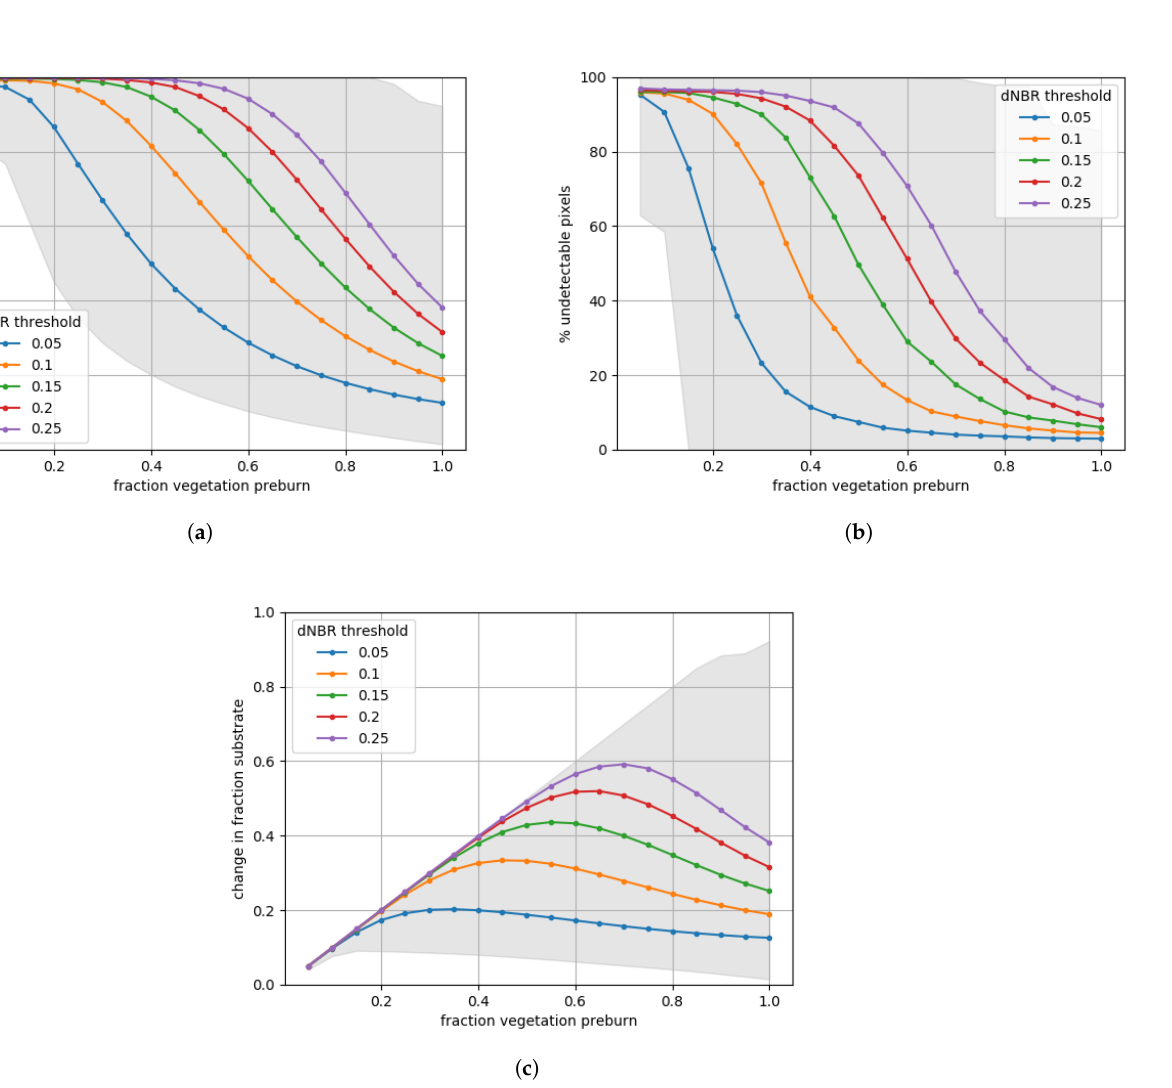
Figure 5. Park-wide detectability results for a vegetation removal scenario without fire ( ∆ char = 0), Landsat 8. The mean values are shown in colored lines, with total model result variation shown in gray. ( a ) Fraction of vegetation burned at detection. ( b ) Percentage of undetectable pixels. ( c ) Increase in substrate fraction on